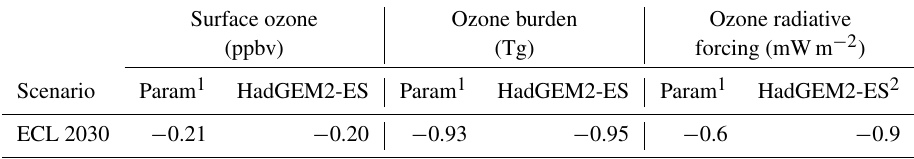
Table 5. Parameterised responses based only on HadGEM2-ES input for annual mean surface ozone, global ozone burden and ozone radiative forcing using the ECLIPSE CLE emission scenarios in 2030, with changes calculated relative to the year 2010.